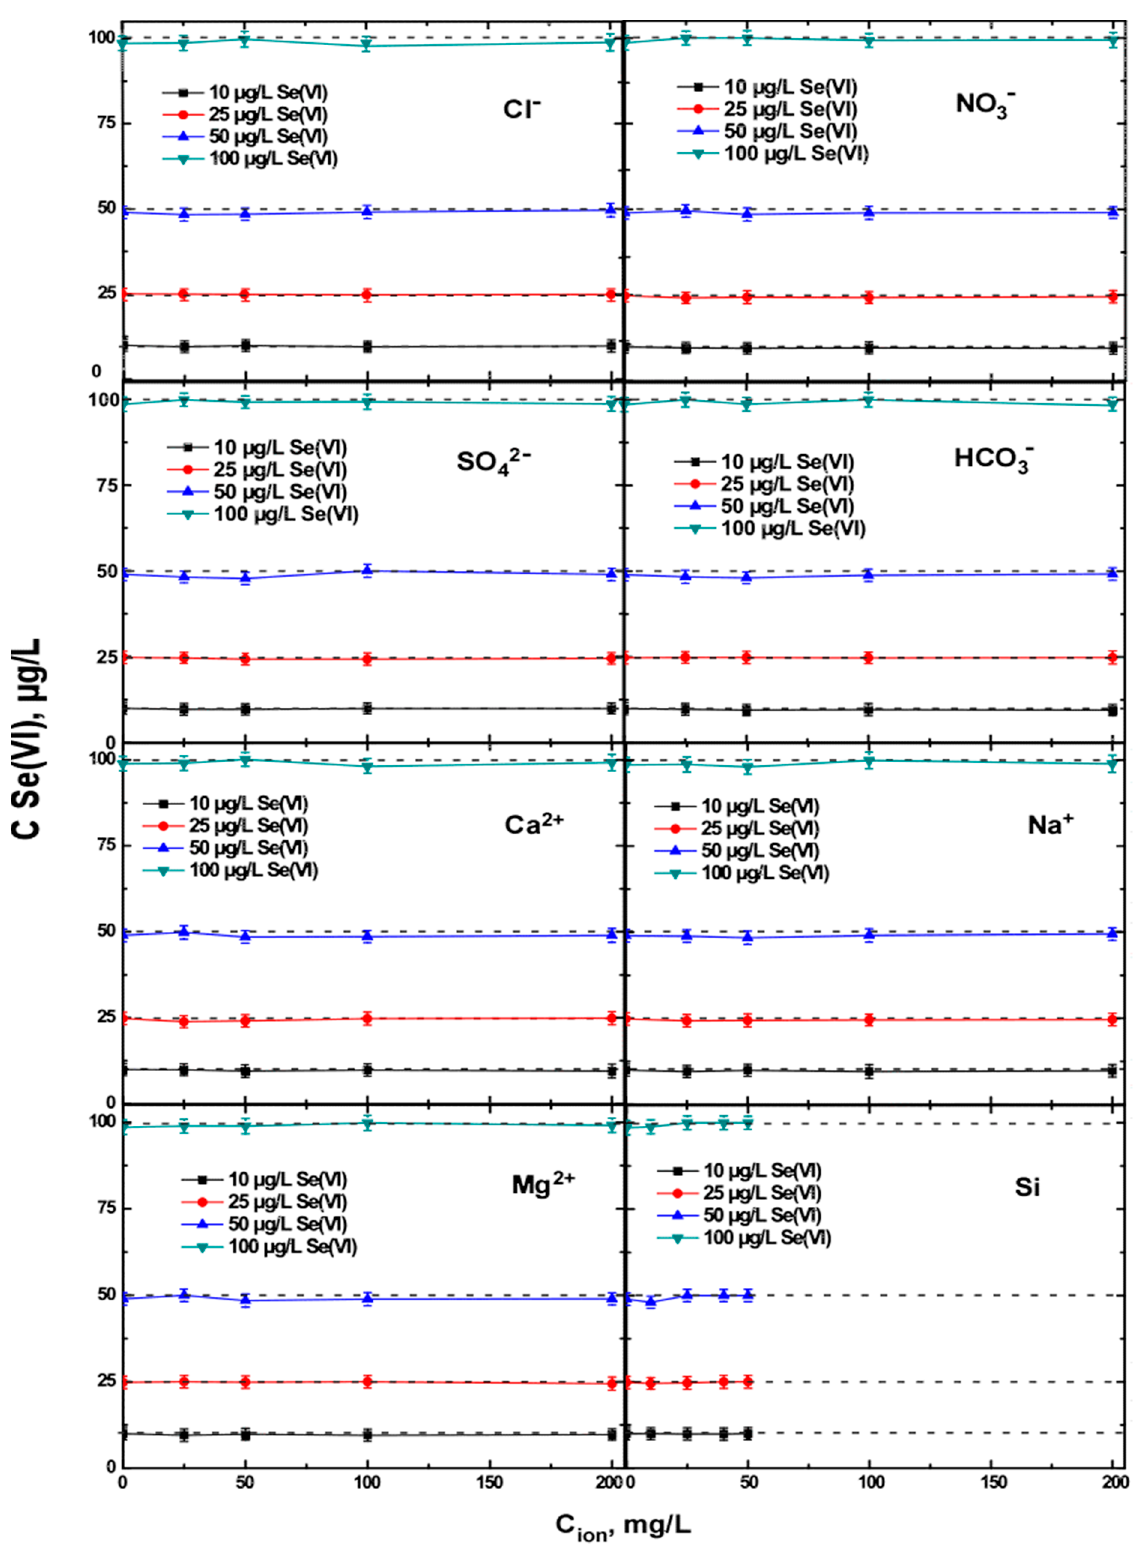
Figure 7. Influence of common water ions on the Se(VI) adsorption by Bayoxide. Experimental conditions: Bayoxide concentration 0.5 g/L, initial Se(VI) concentration range 10–100 μ g/L, pH 7.3 ± 0.2, temperature 20 °C, and contact time 30 min.